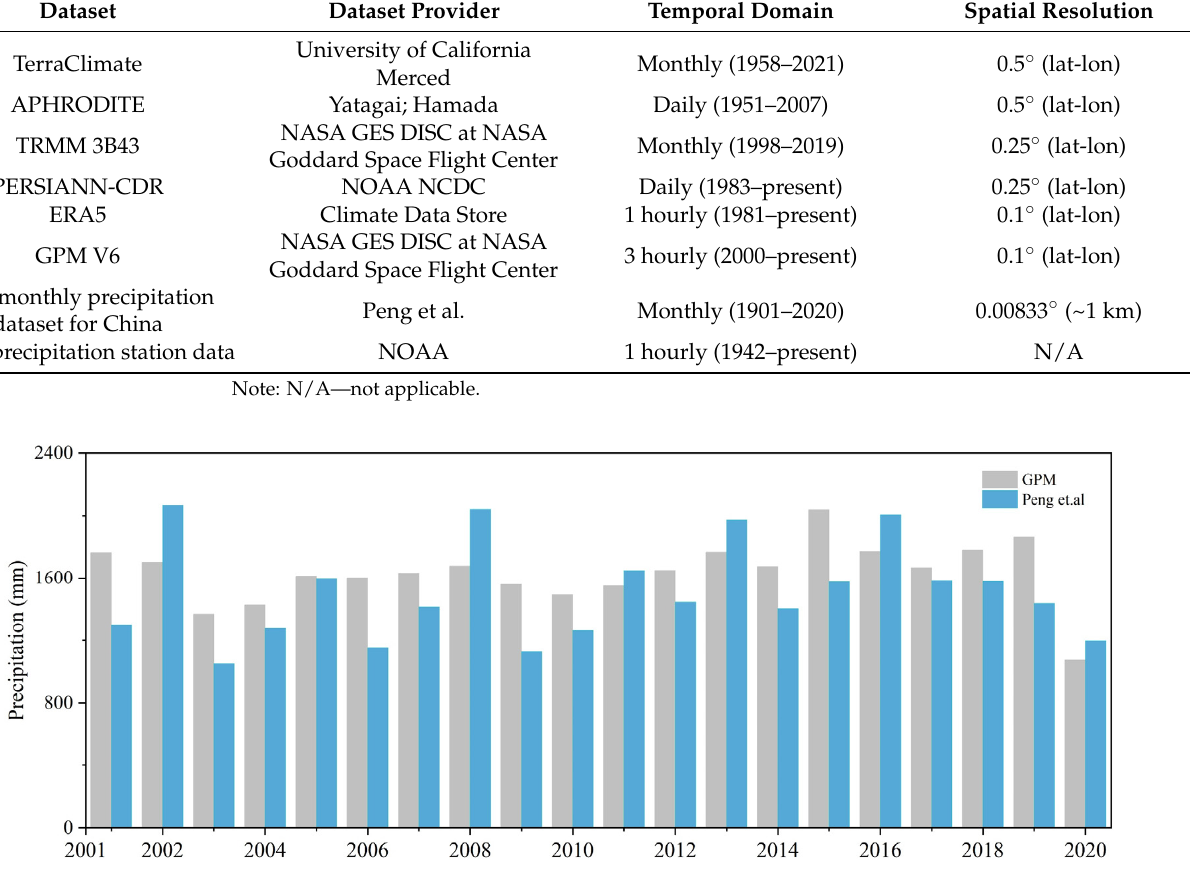
Figure 11. Comparison of rainfall data with GPM data from Peng et al.[43].